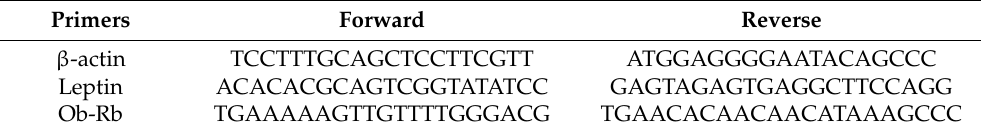
Table 1. Sequences of the primers.